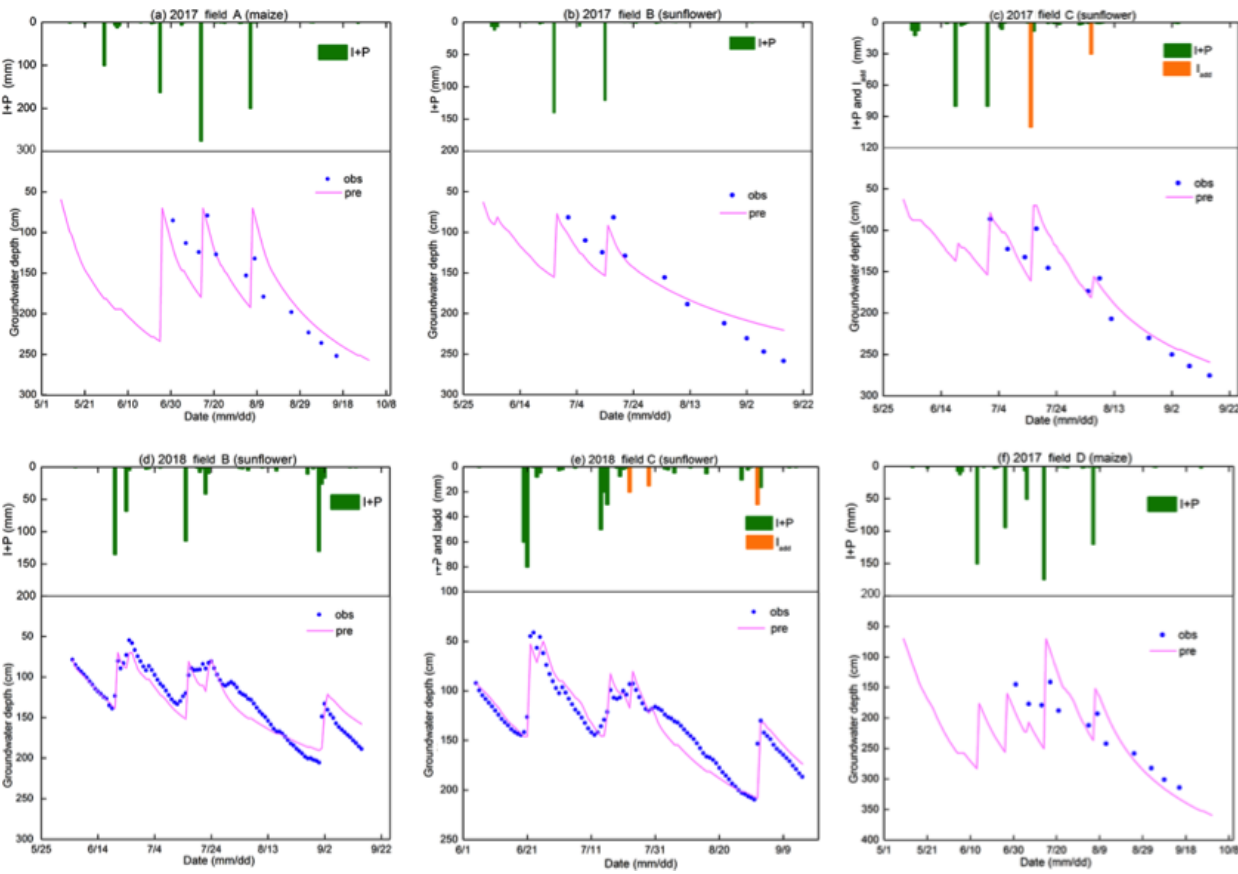
Figure 7. Observed (blue dots) and simulated groundwater depth of the experimental fields in Shahaoqu during model calibration (a–c) and validation (d–f) .